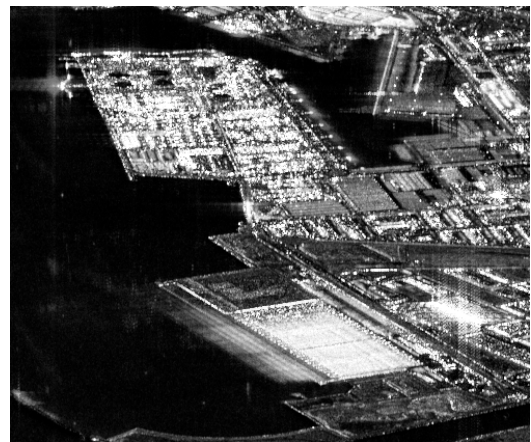
Figure 1. Mean SAR amplitude of the first test area: 401 (range) by 351 (azimuth) pixels, which cover an extension of approximately 1.6 (range) by 4.9 (azimuth) km.